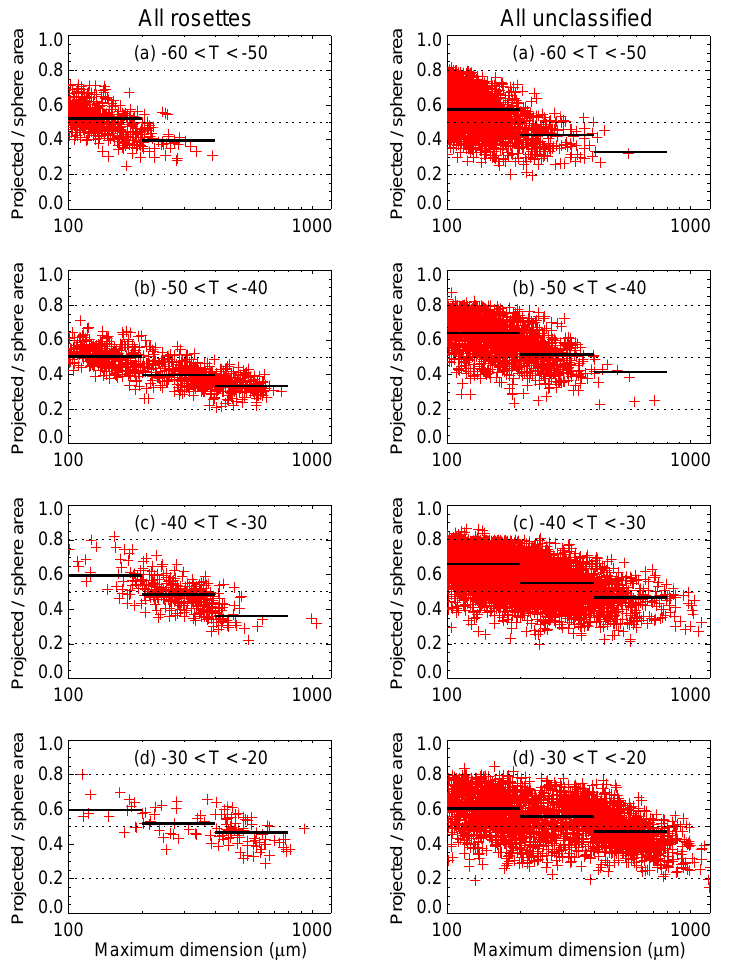
Figure 12. Ratio of measured A p to area of a sphere with diameter D max in four temperature ranges for all bullet rosettes (left column) and all unclassified crystals (right column). Overplotted solid line segments indicate median value over D max -doubling